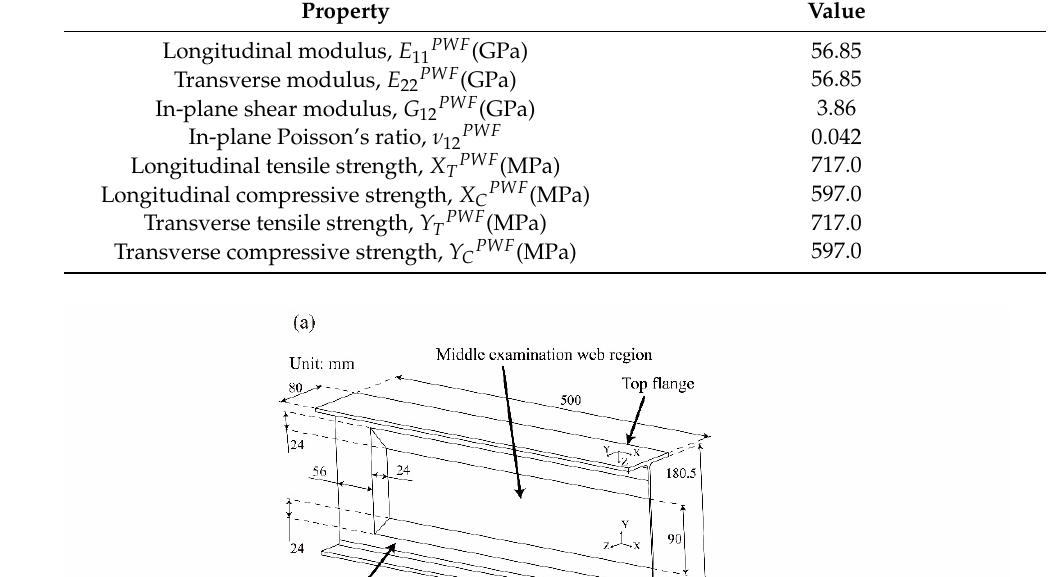
Table 1. Mechanical properties of the T300/Epoxy PWF composite in the tested I-section beams. Property